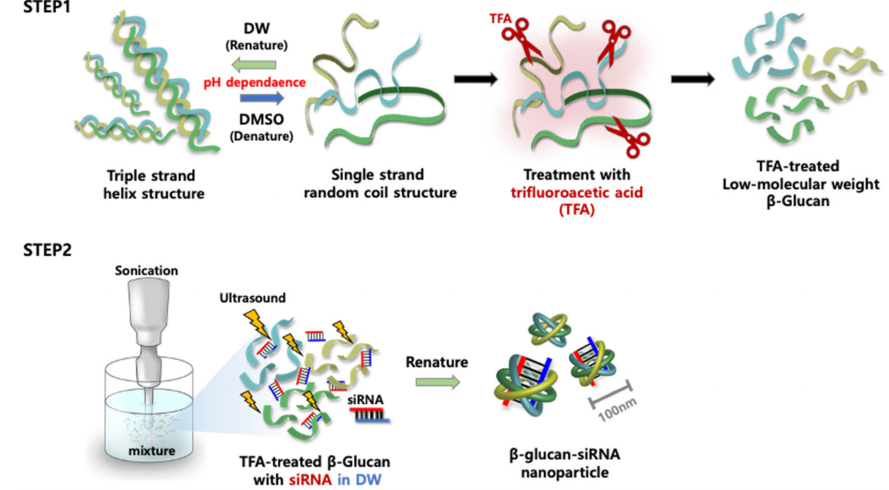
Figure 1. A schematic illustration of the preparation of siRNA-loaded β -glucan nanoparticles. Step 1 is preparing single strand β -glucan chains later cut with trifluoroacetic acid (TFA). Step 2 is promoting a binding reaction between siRNA and β -glucan structures. DW, deionized water; DMSO, dimethyl